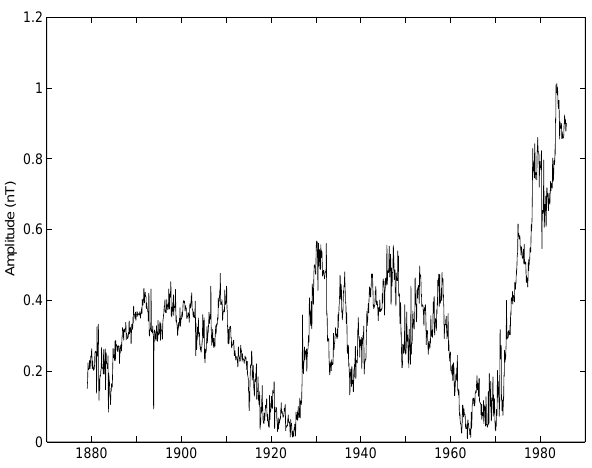
Fig. 6. Time variation of the amplitude of the aa -index annual vari- ation, computed using a 22-year sliding window, centered.